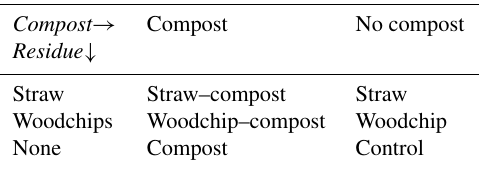
Table 1. Treatment structure composed of the factors residue and